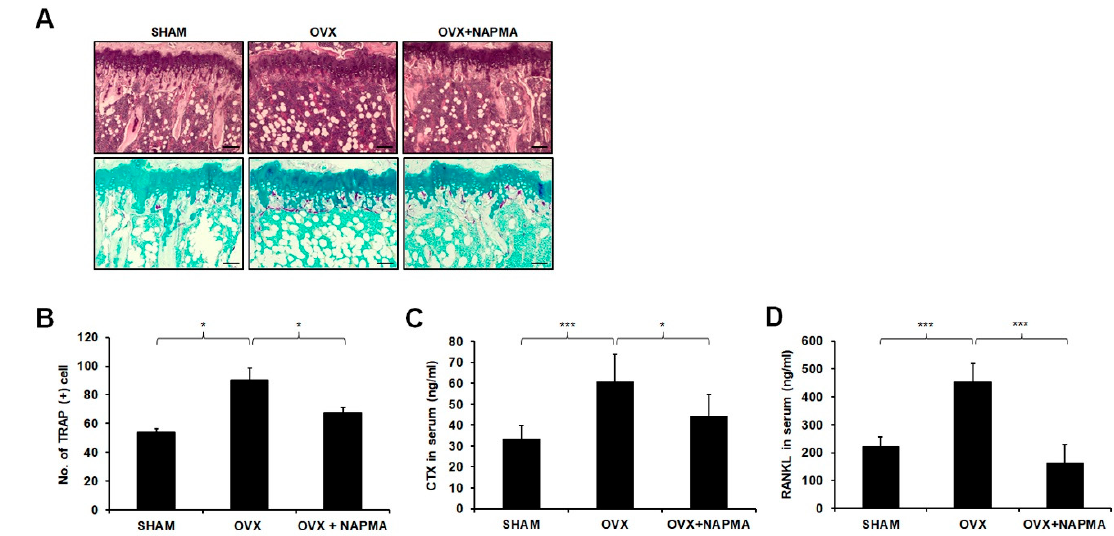
Figure 6. ( A ) Representative hematoxylin and eosin (H&E) and TRAP staining of decalcified femur sections from sham, OVX, and OVX + NAPMA mice from each group at six weeks after the operation. Scale bar = 200 μ m. ( B ) The number of Trap-positive cells was quantified via TRAP-staining. Serum levels of ( C ) CTX-1 and ( D ) RANKL in mice treated with NAPMA. Mice received a sham operation or ovariectomy as described and were treated with a vehicle or NAPMA (10 mg/kg/each day) for six weeks. The serum was collected before the animals were euthanized. The data are presented as the mean ± SD. N = 6. * p < 0.05; *** p < 0.001.